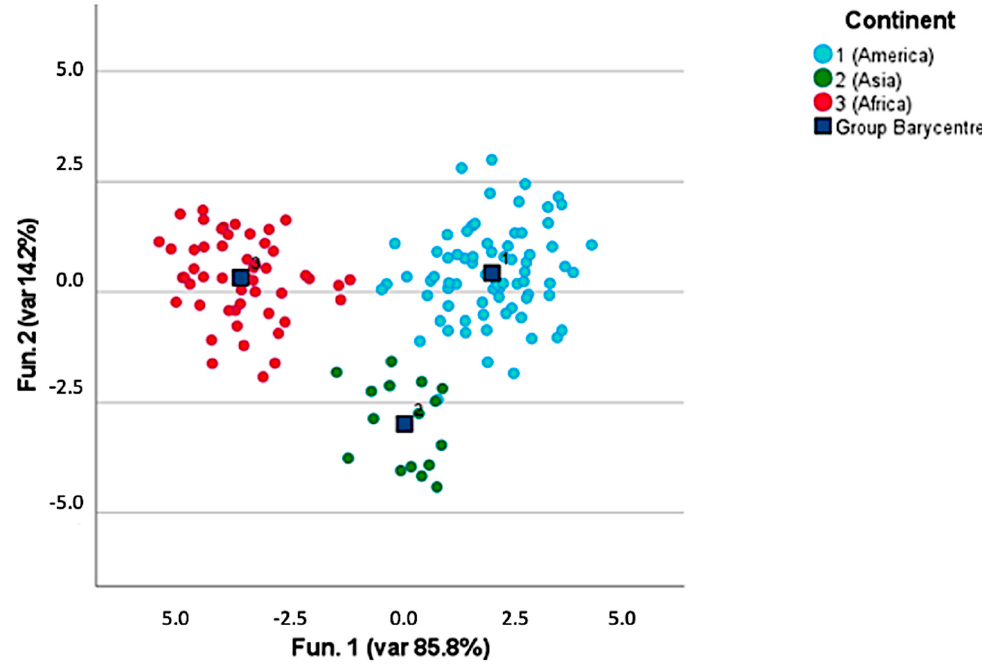
Figure 4. Discrimination of the continents of origin of roasted coffee samples.